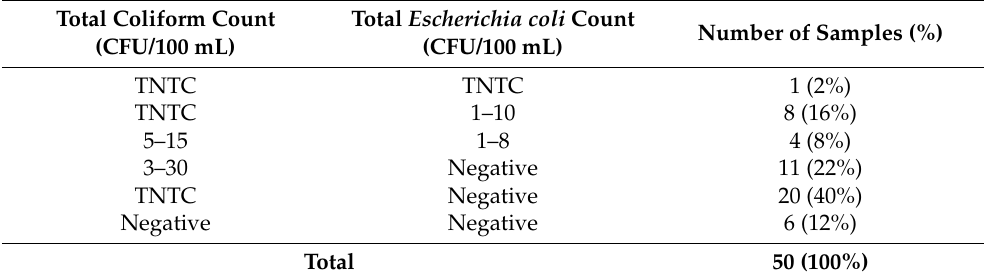
Table 2. Total microbial and total coliform counts found in water samples used for reconstitution of drugs in Jordanian community pharmacies.